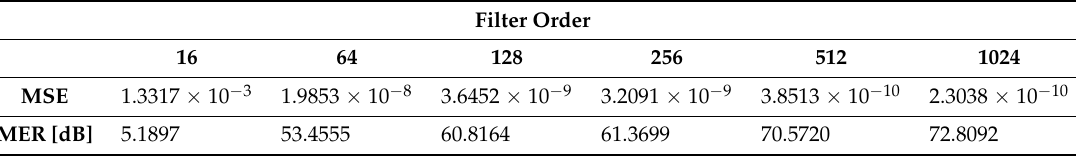
Table 4. MSE and MER for several different filter